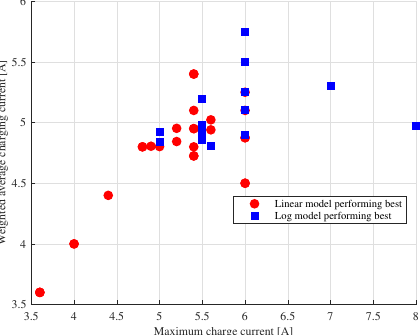
Figure 6. Maximum and weighted current during fast charging for the batteries with a difference in R 2 higher than 1%.